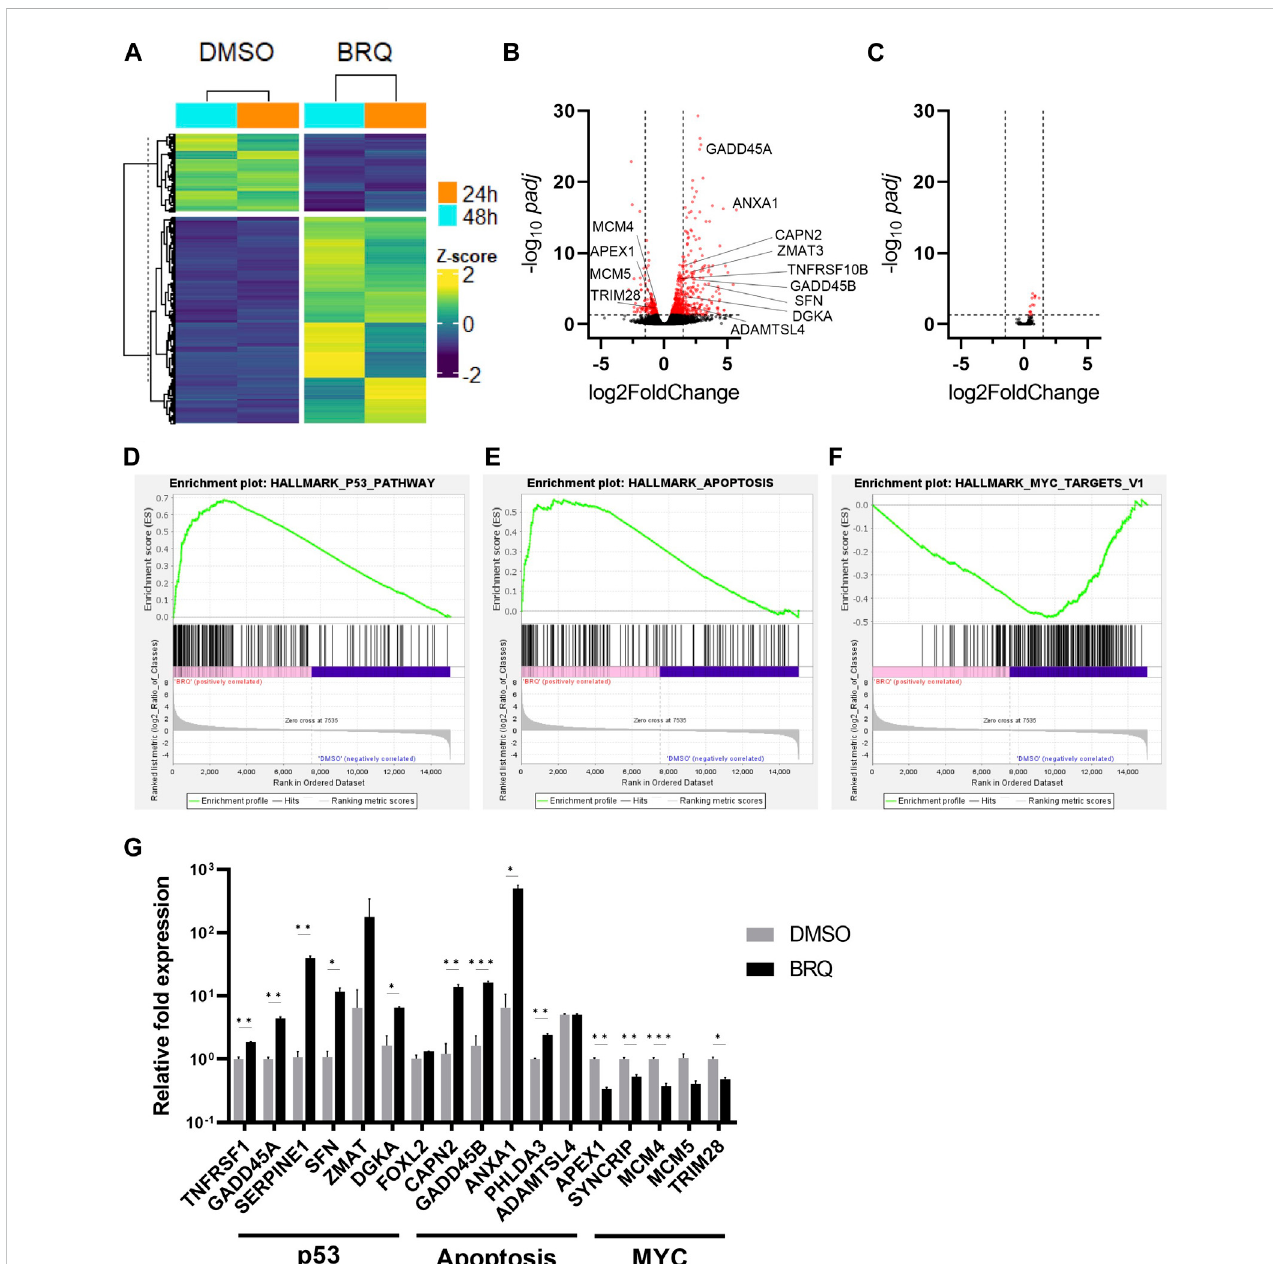
FIGURE 3 Relevant transcriptional changes of BRQ-treated hiPSCs. (A) hiPSCs treated for 24 h and 48 h, hieratical clustering of samples of the signi fi cantly differentiallyexpressedgenes(100 nMBRQvs.DMSOcontrol),brightyellowcolorindicateshigherexpressionofgeneandblueforlowerexpression.Volcano plots of signi fi cance (-log10 padj ) vs. log2 fold change showing the differentially expressed genes of 100 nM BRQ vs. DMSO control of (B) hiPSCs, and (C) iMSCs. Red color dots indicate genes showing signi fi cantly differentially expressed genes ( p ≤ 0.05 horizontal dashed) that are transcriptionally downregulated or upregulated (log2Fold change ≥ 1.5 or ≤ -1.5 vertical dashed lines). Gene Set Enrichment Analysis (GSEA) of the normalized counts data of BRQ- and DMSO-treated hiPSCs shows a correlation with (D) Apoptosis targets, (E) p53 pathway, and (F) MYC targets. (G) 48 h BRQ-treated hiPSCs relative mRNA expression of Apoptosis, p53, and MYC targets detected by RT-qPCR, bars indicate the mean, error bars indicate S.D., n = 3, biological